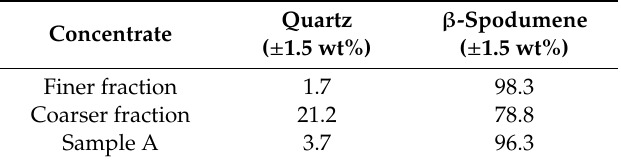
Table 2. Rietveld analyses of the converted concentrate.